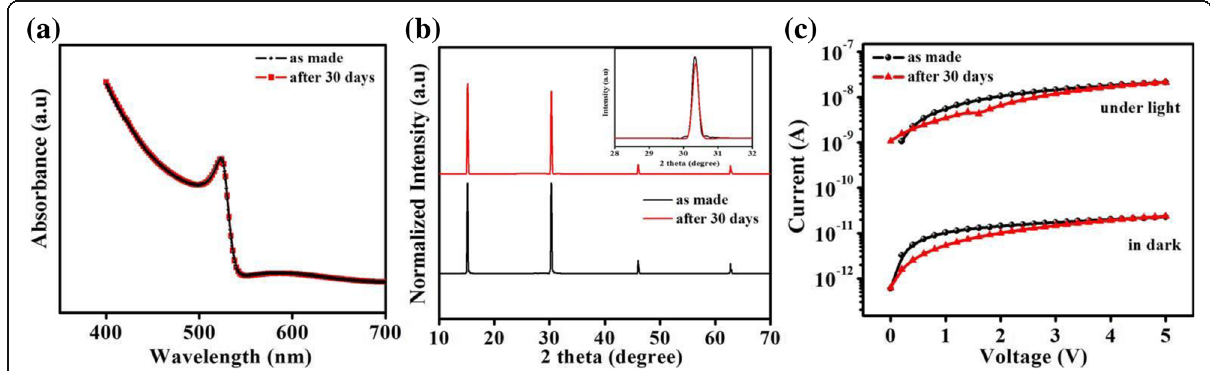
Fig. 7 a Visible absorption spectra. b XRD spectra. c I – V curves of the trilayer photodetector as made and after 30 days in ambient environment (under the white light intensity of 0.5 mW cm − 2